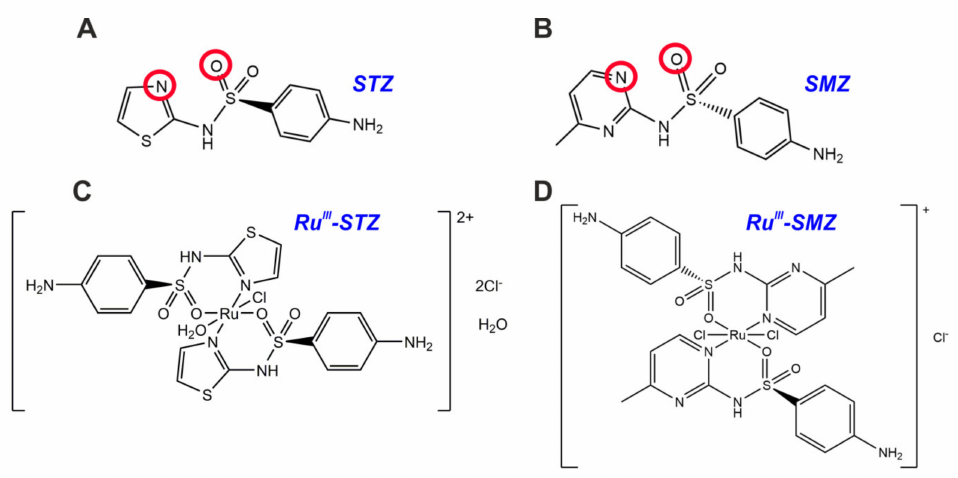
Figure 2. Structure of free ligands: ( A ) STZ, ( B ) SMZ (together with their donors’ atoms) and their Ru(III) coordination compounds: ( C ) [RuCl(OH 2 )(STZ) 2 ]Cl 2 · H 2 O; ( D ) [RuCl 2 (SMZ) 2 ]Cl emerged from the experimental